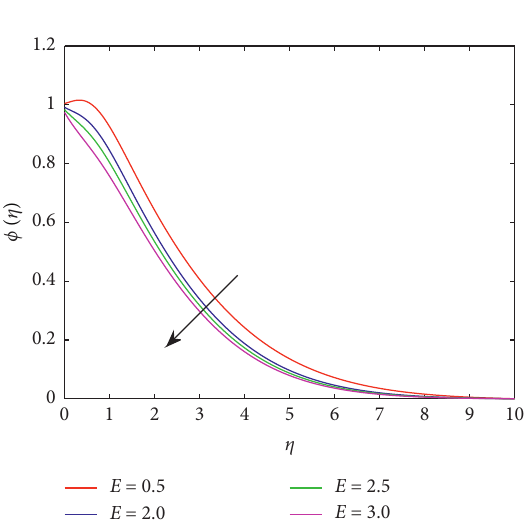
Figure 12: Variation due to δ